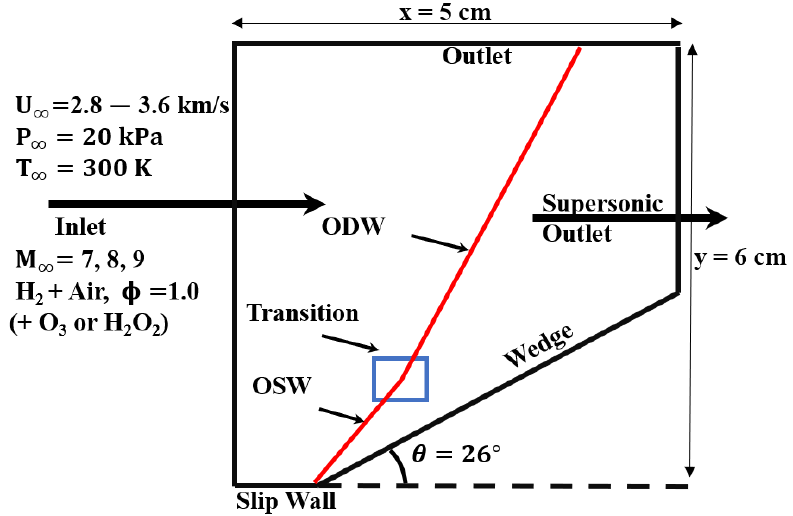
Figure 1. Computation domain and boundary conditions.